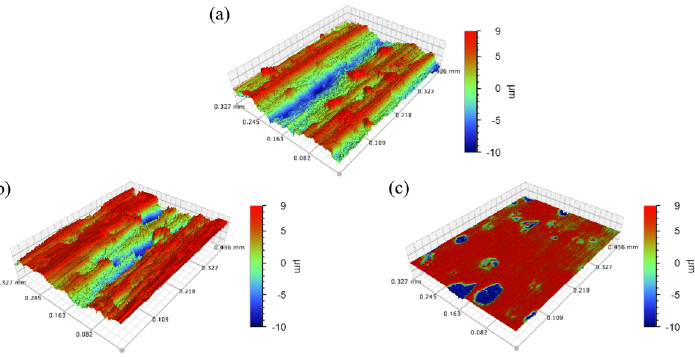
Figure 7. The 3D topography of the grinding surface: ( a ) Before grinding (Ra = 1.541 μm), ( b ) Dry grinding after 16 passes (Ra = 0.952 μm), ( c ) Wet grinding after 16 passes (Ra = 0.19 μm).